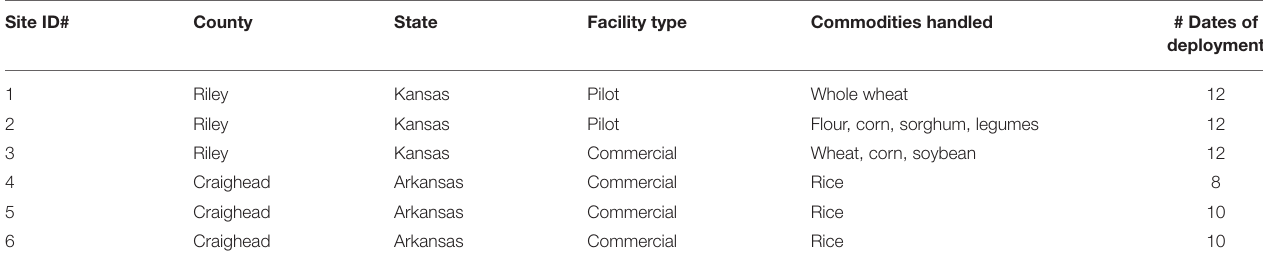
TABLE 1 | Summary of field sites used for the interception trap assay in 2018 and 2019 in Kansas and Arkansas, USA. Site